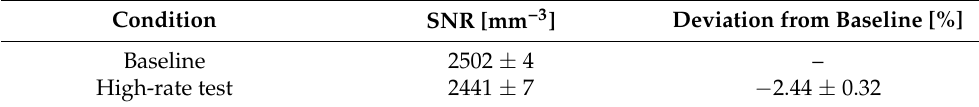
Table 2. SNR values observed in baseline and interference measurement (high decay